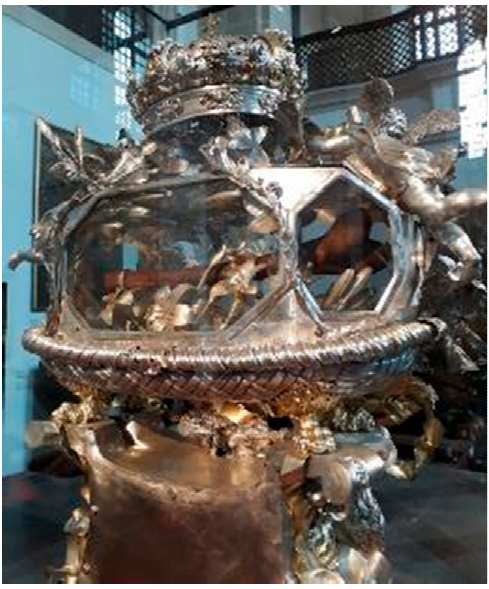
Figure 12. Massimo Soldani Benzi and Grand Ducal Galleria , Reliquary of St. Kazimierz Jagiello´nczyk, 1687–1688 (rear view). Museo delle Cappelle Medicee, Church of San Lorenzo, Florence. Photo by the author.